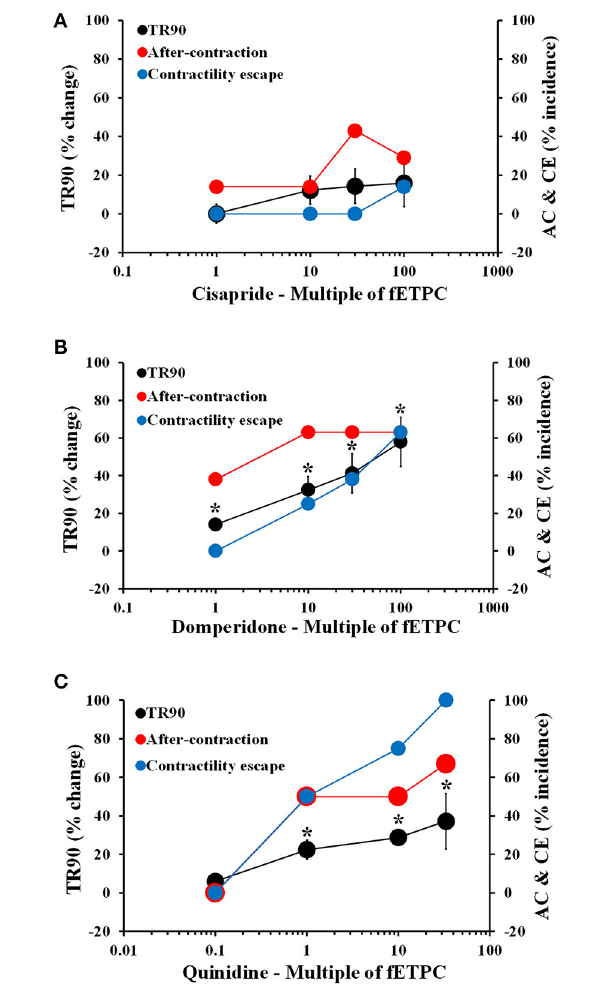
FIGURE 3 | Mean % change in TR90 and AC & CE % incidence when cardiomyocytes were treated with cisapride (A) , domperidone (B) and quinidine (C) . * P < 0.05 vs. values from vehicle.